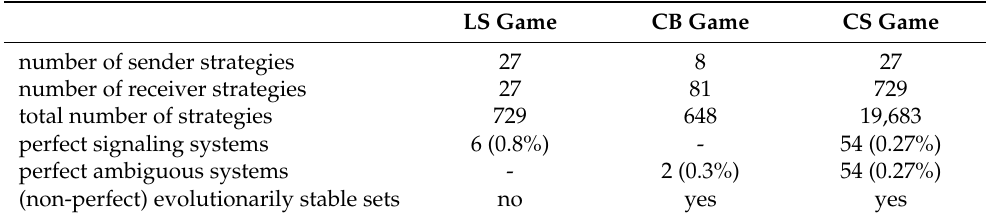
Table 3. Strategic/evolutionary properties of the three